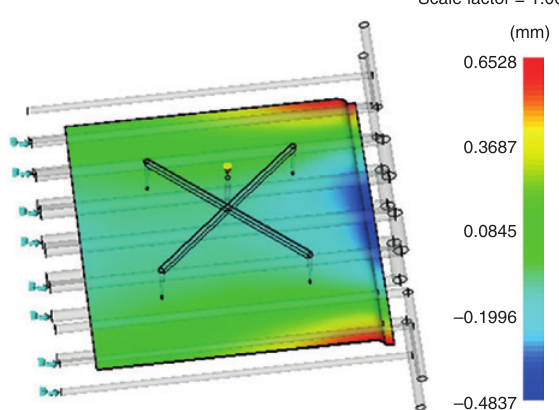
Figure 13: The comparison of standard Figure 10: The plastic part deformation caused by mold cavity. Deflection, all effects: Z component Scale factor = 1.000